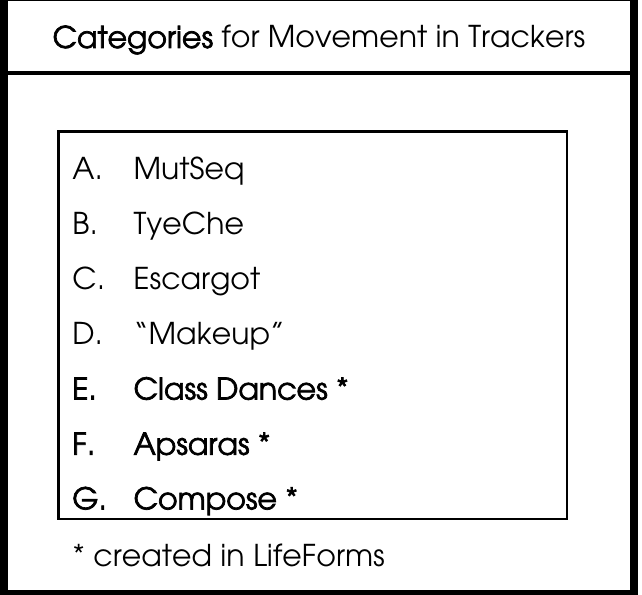
Figure 4.3. Trackers Movement